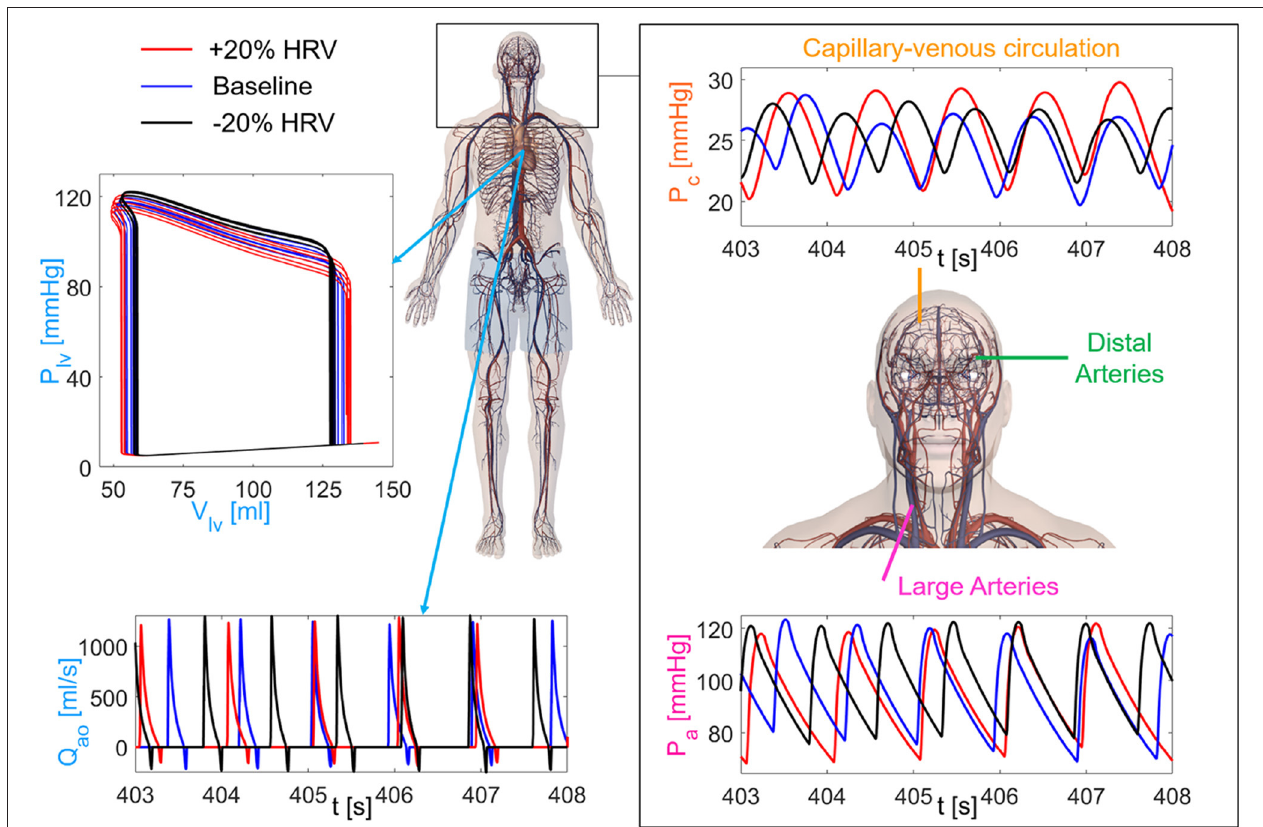
FIGURE 2 | Sketch of the cardiovascular-cerebral model for the three HRV configurations (red: increased HRV, blue: baseline, black: decreased HRV). (Left) Central and systemic-pulmonary circulation with representative time-series of the aortic flow rate ( Q ao ) and left ventricle PV loops (5 s length). (Right) Cerebral circulation with the three main regions (large arteries, distal arteries, capillary-venous circulation), together with examples of the systemic arterial pressure, P a (Bottom), and cerebral capillary pressure, P c (Top), time-series.